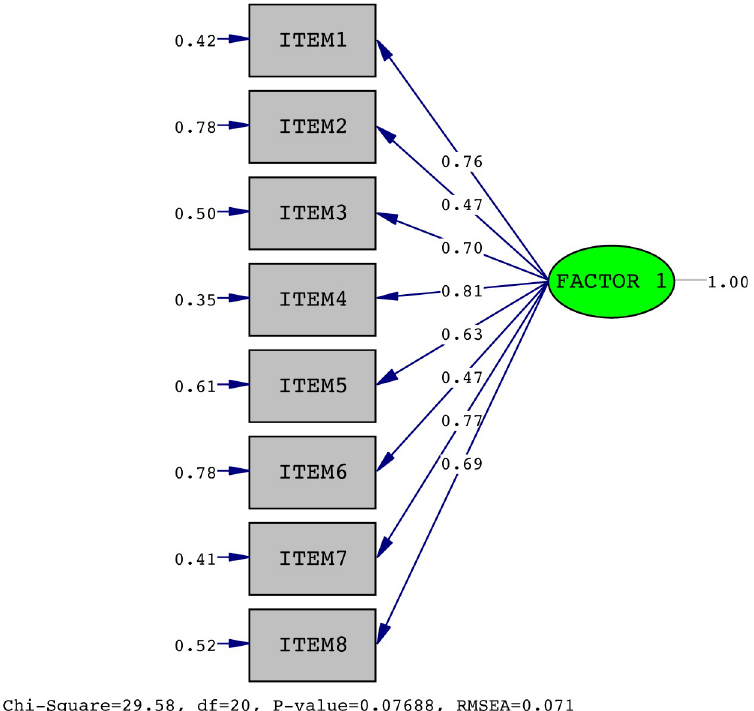
Fig 2. The x 2 test for the 1-factor model Lysholm